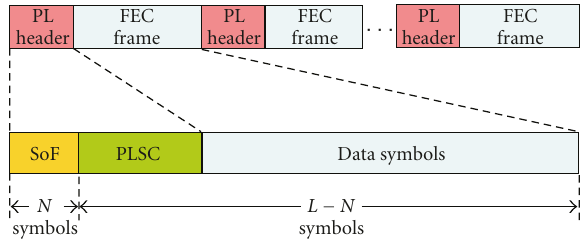
Figure 1: The frame structure for DVB-S2 which includes the start- of-frame (SoF) synchronization sequence of length N =